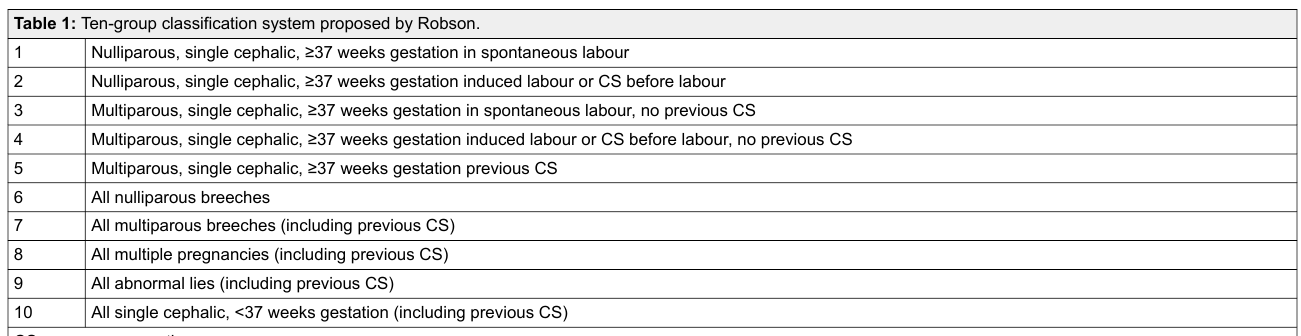
Table 1: Ten-group classification system proposed by